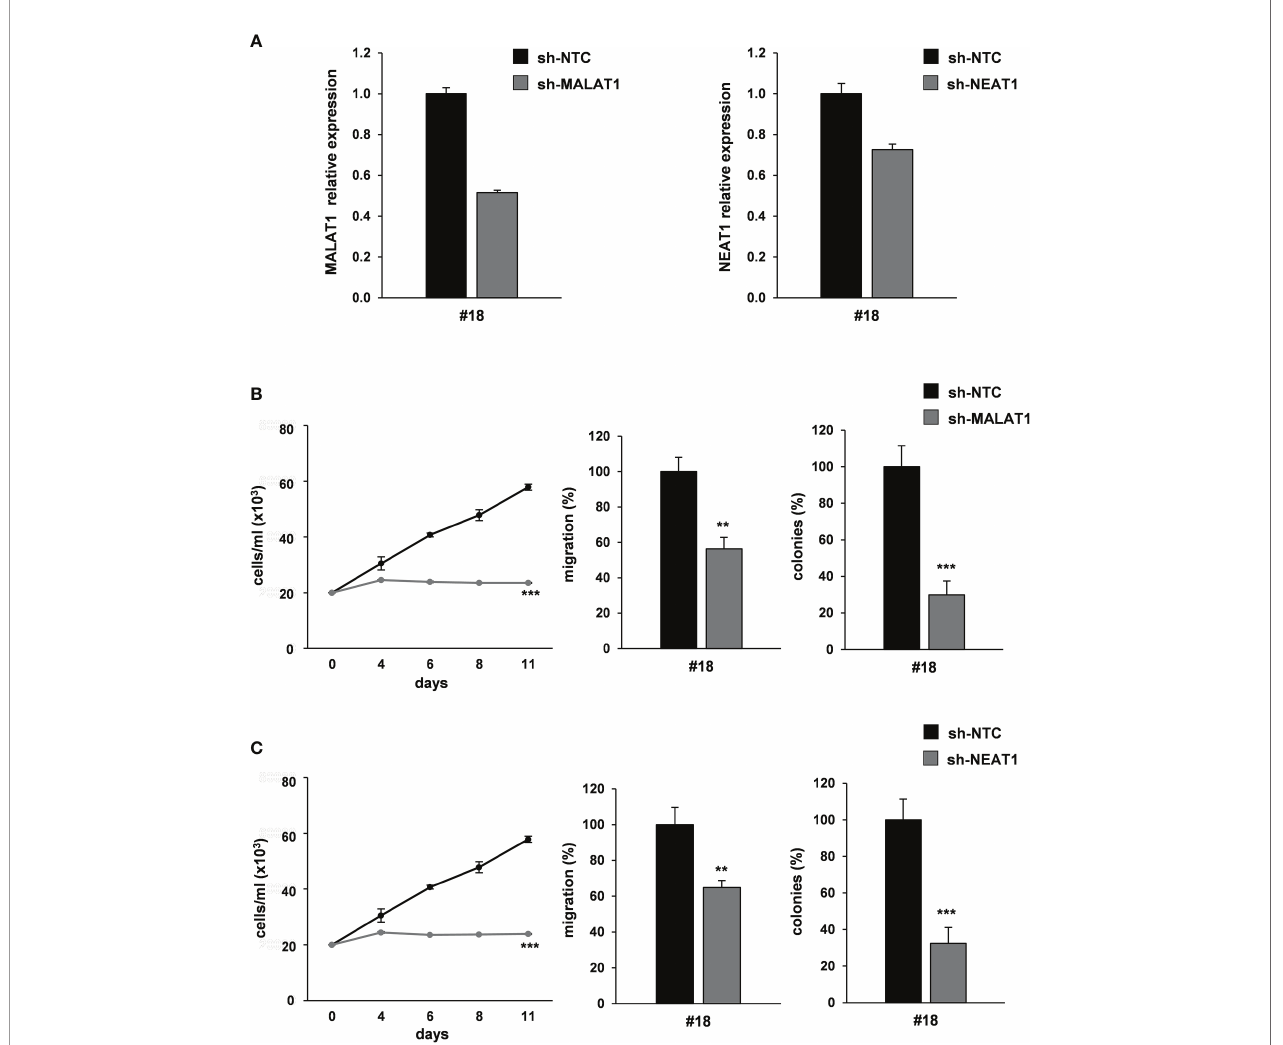
FIGURE 6 | MALAT1 and NEAT1 knockdown recapitulates the effect of miR-378a-3p restoration on CRC-SC tumorigenicity. (A) qRT-PCR analysis for MALAT1 ( left panel ) and NEAT1 ( right panel ) on CRC-SC#18 transduced with sh-NTC, sh-MALAT1 or sh-NEAT1 vector con fi rmed lncRNA downregulation. (B) Functional in vitro assays: growth curve ( left panel ), migration assay ( center panel ) and colony formation assay ( right panel ) of CRC-SC#18 transduced with sh-NTC or sh-MALAT1 vectors. Values shown are mean ± SD from two independent experiments in triplicate. **p<0.01; ***p<0.001 based on Student ’ s t test. (C) Functional in vitro assays: growth curve ( left panel ), migration assay ( center panel ) and colony formation assay ( right panel ) of CRC-SC#18 transduced with sh-NTC or sh-NEAT1 vectors. Values shown are mean ± SD from two independent experiments in triplicate. **p<0.01; ***p<0.001 based on Student ’ s t